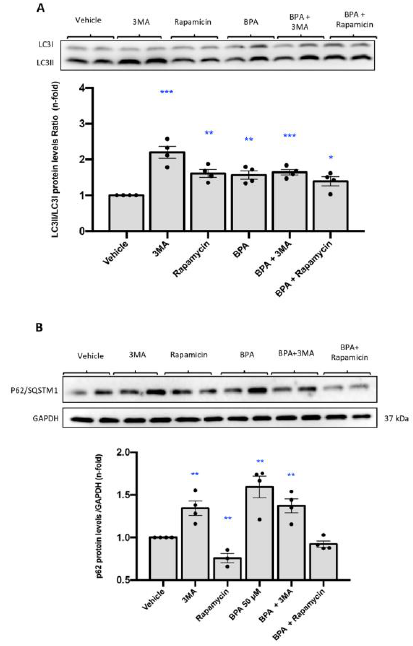
Figure 6. Treatment with BPA causes LC3B accumulation in cultured renal cells compared to 3MA and Rapamycin. ( A ) HK2 cells were treated with BPA at dose of 50 µ M for 24 h. The level of LC3II/I was detected by Western blot. LC3II/I protein levels ratio of. BPA treatment induced p62/SQSTM1 accumulation in HK2 cells compared to 3MA and Rapamycin. ( B ) HK2 cells were treated with BPA at dose of 50 μM for 24 h. The level of p62/SQSTM1 was detected by Western blot. p62/SQSTM1 protein levels quantification. All data are presented as the mean ± SEM of 4 experiments, * p <0.05; ** p < 0.01; *** p <0.001 vs. control.